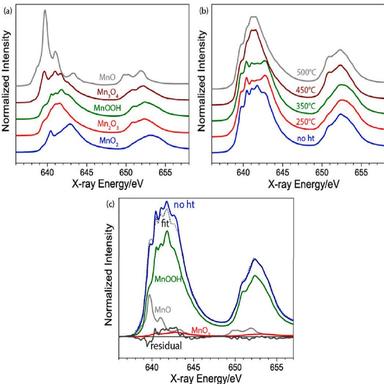
Mn L-edge XAS (TEY) measurements of (a) five standards: MnO, Mn3O4, MnOOH, Mn2O3, and MnO2 and (b) MnOx thin films exposed to five heat treatment conditions: no heat treatment ("no ht"), heat treatment at 250 ◦C, 350 ◦C, 450 ◦C, and 500 ◦C. (c) Sample fittings for the as-prepared "no ht" sample.